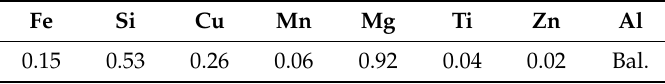
Table 1. Composition of AA6061 alloy